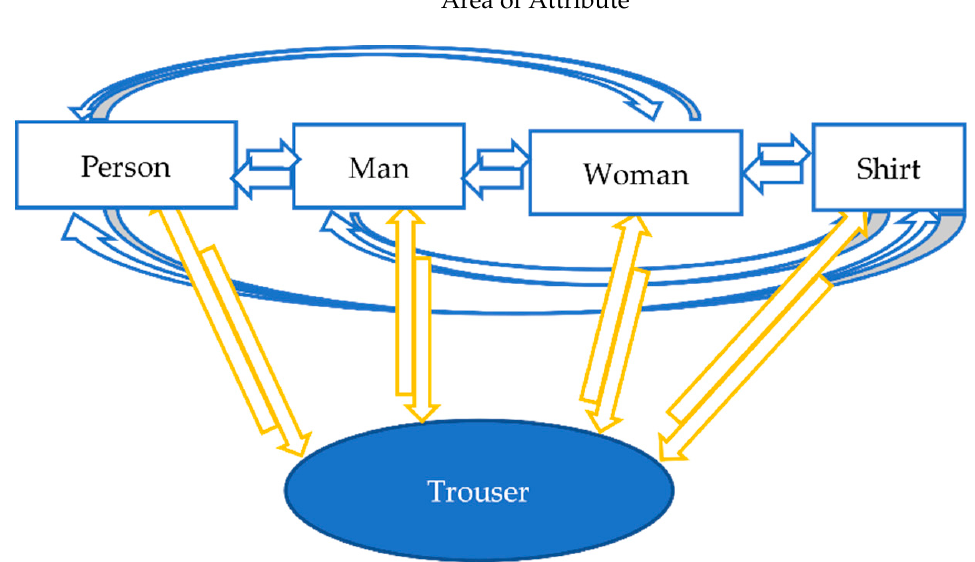
Figure 6. A combination of distributed-only and semantic hub for controlling the relationship between attributes.